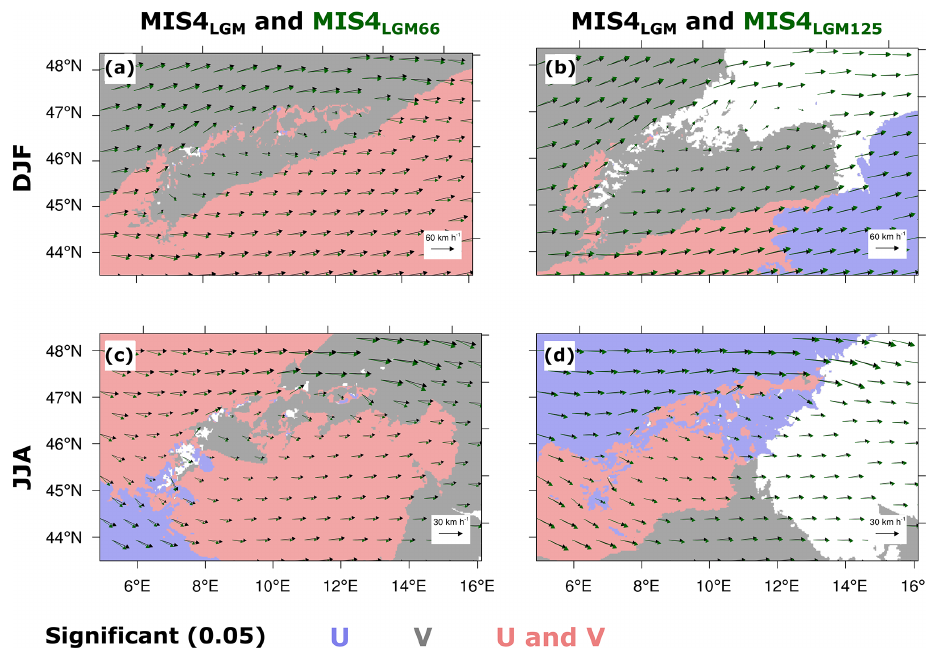
Figure 9. Climatological mean wind vectors over the Alps. Panel (a) represents wind vectors for DJF, black and green vectors correspond to MIS4 LGM and MIS4 LGM66 , respectively, (b) as panel (a) but green vectors to MIS4 LGM125 . (c, d) As panels (a) and (b) but for JJA. Red shading indicates statistically significant differences in zonal ( U ) and meridional ( V ) wind components at a significance level of 0.05 (two-tailed bootstrapping technique), blue and grey shading as the red one but only in U and V wind components, respectively. Please note that the reference wind vectors differ for DJF and